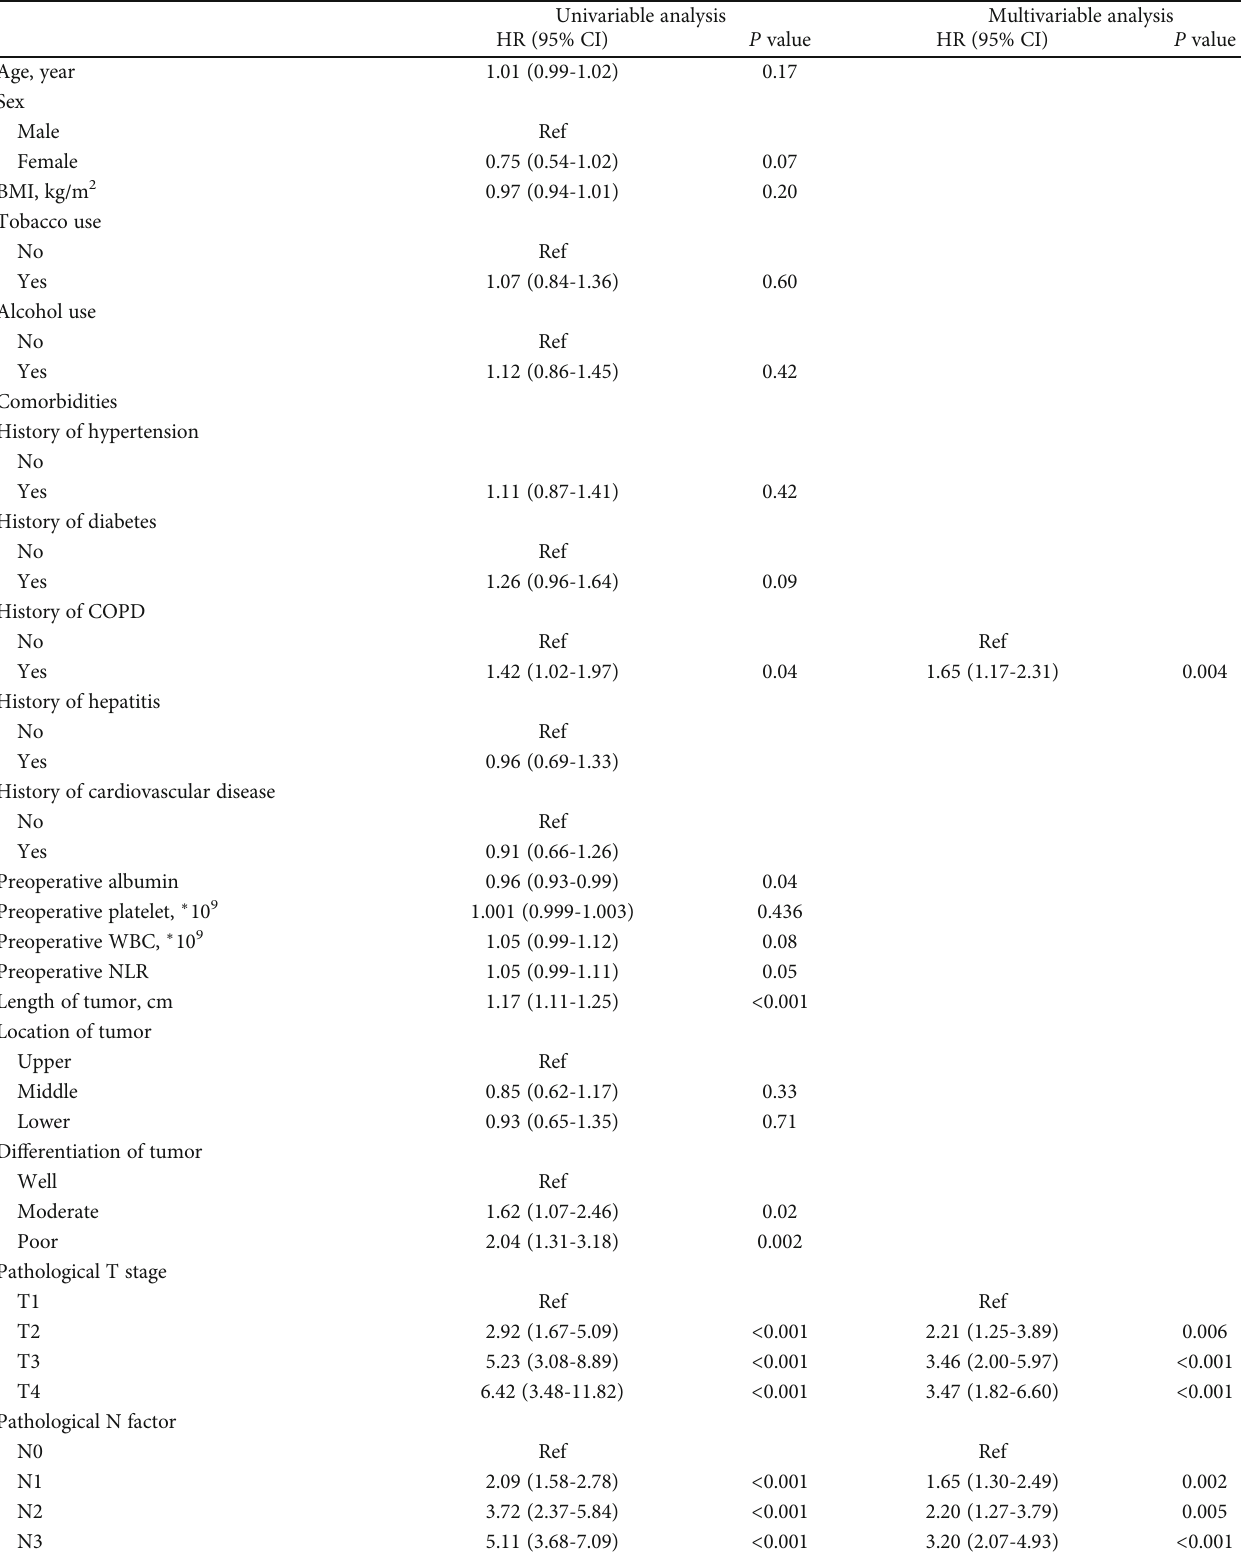
Table 3: Univariable and multivariable Cox analysis of prognostic factors for disease free survival in 503 patients with esophageal squamous cell